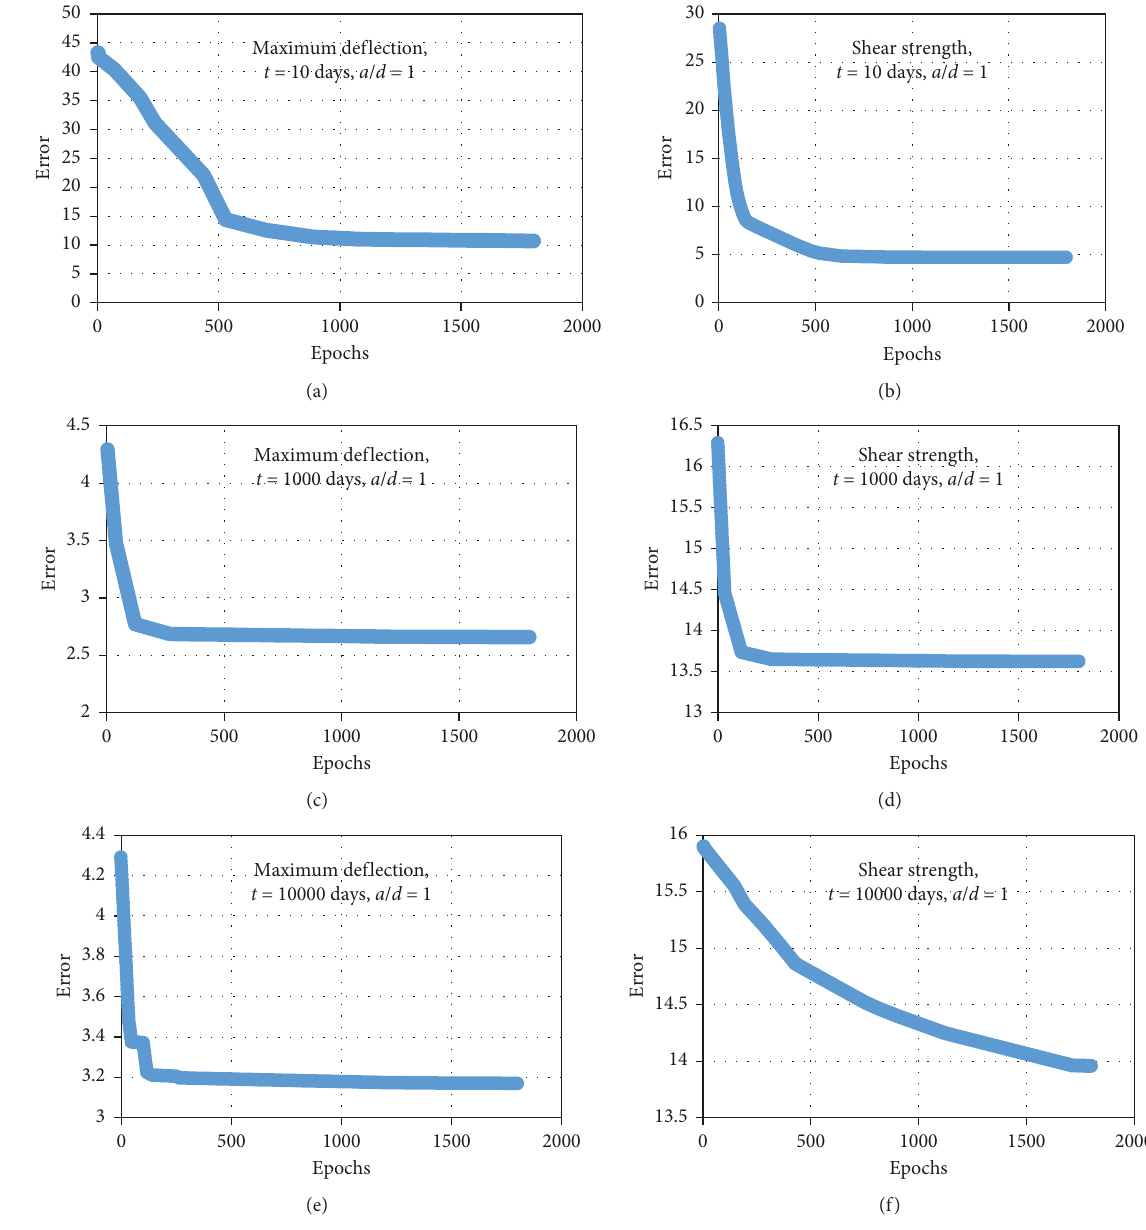
Figure 6: Process of stabilizing the ANFIS model by minimizing the